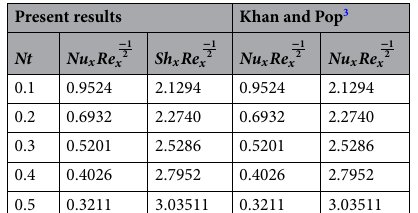
Table 3. Comparison of numerical values of Nu x Re −